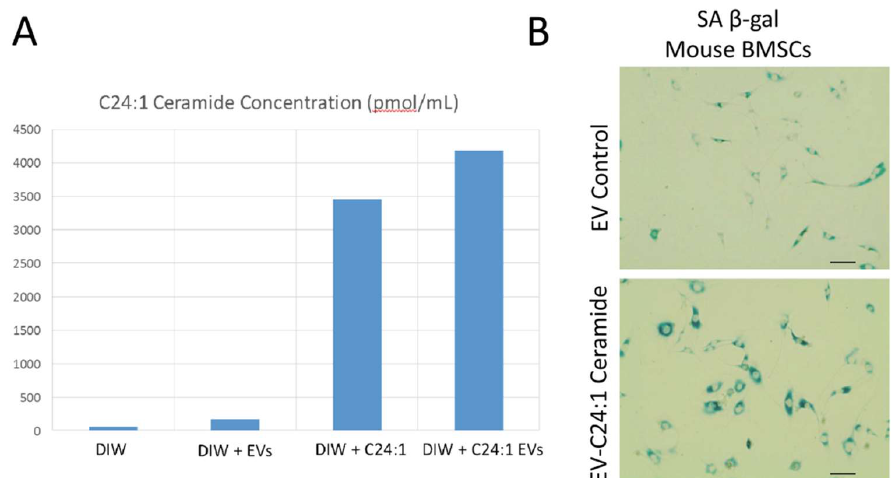
Figure 3. EVs loaded with C24:1 ceramide induce cellular senescence. ( A ) Lipidomic profiles of de-ionized water alone (DIW), DIW + EVs, DIW + C24:1 ceramide, or DIW + EVs loaded with C24:1 ceramide. Bars represent a single sample. ( B ) Staining for β-gal indicated increased senescence in BMSCs treated with C24:1 ceramide-loaded EVs. Scale bars = 40 μm.